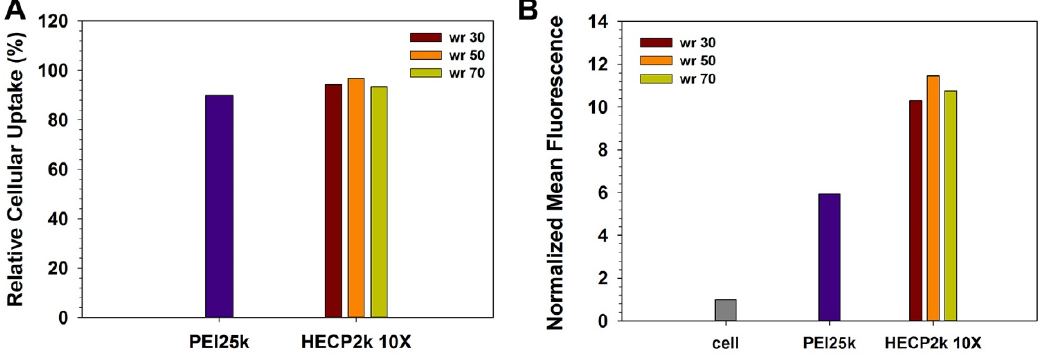
Figure 5. Flow cytometry results of HECP2k 10X polyplexes in HeLa cells at the various weight ratios. ( A ) Relative cellular uptake and ( B ) normalized mean fluorescence unit of polyplexes. PEI25k polyplexes (wr = 1) were used as control.